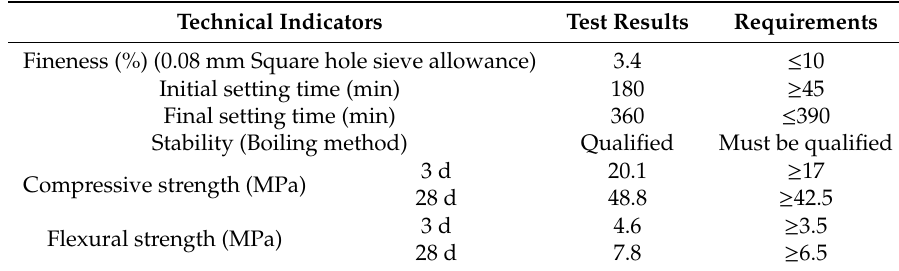
Table 2. Technical properties of P · O